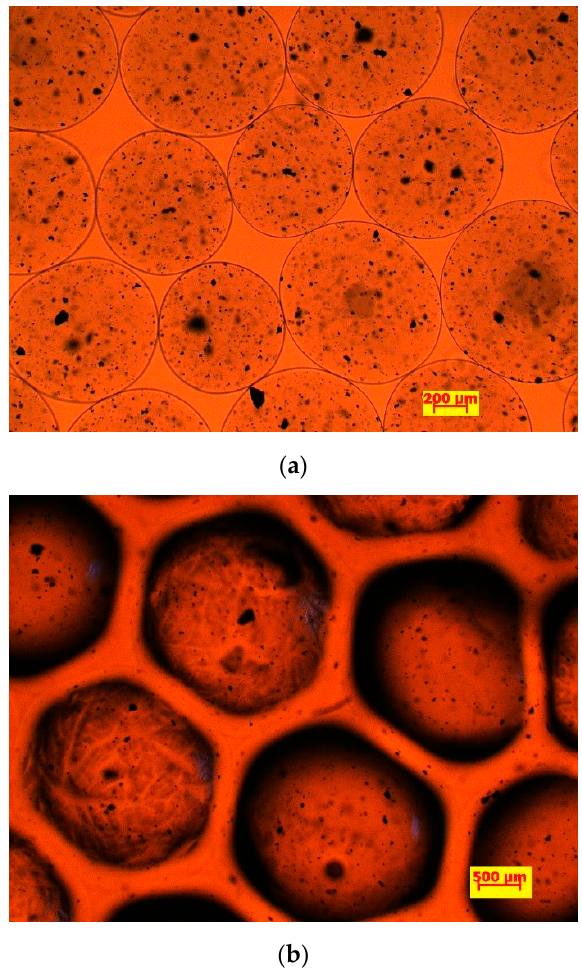
Figure 1. MABs at 5× magnification (1:4 Mag-alginate ratio, created with 22G ee ) ( a ) before and ( b ) after immobilization of HRP.